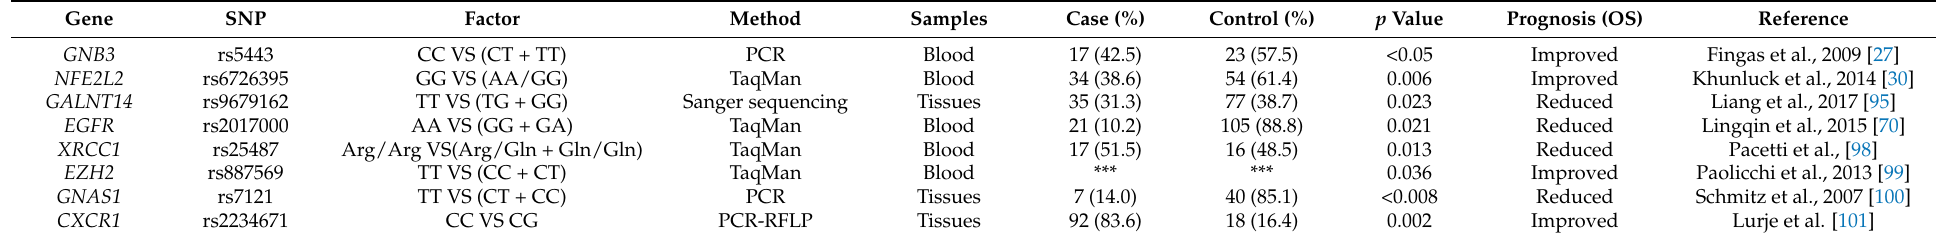
Table 5. Relationship between SNPs and clinical prognosis of cholangiocarcinoma. Various studies investigated the association between SNPs and oncological prognosis of